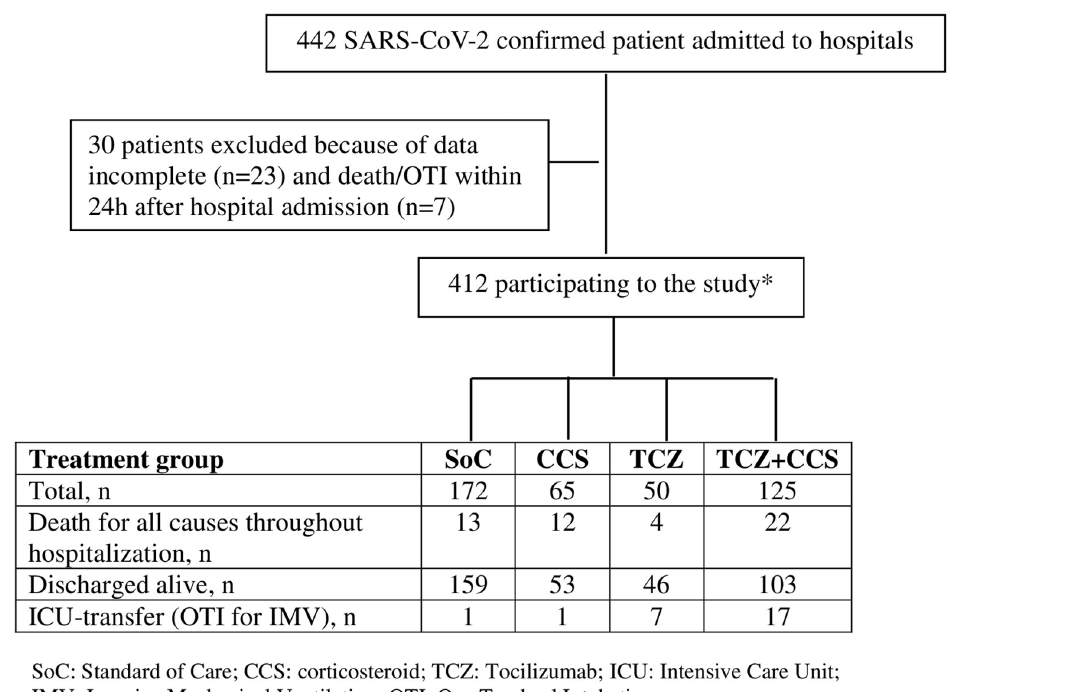
Fig 1. Population study by treatment